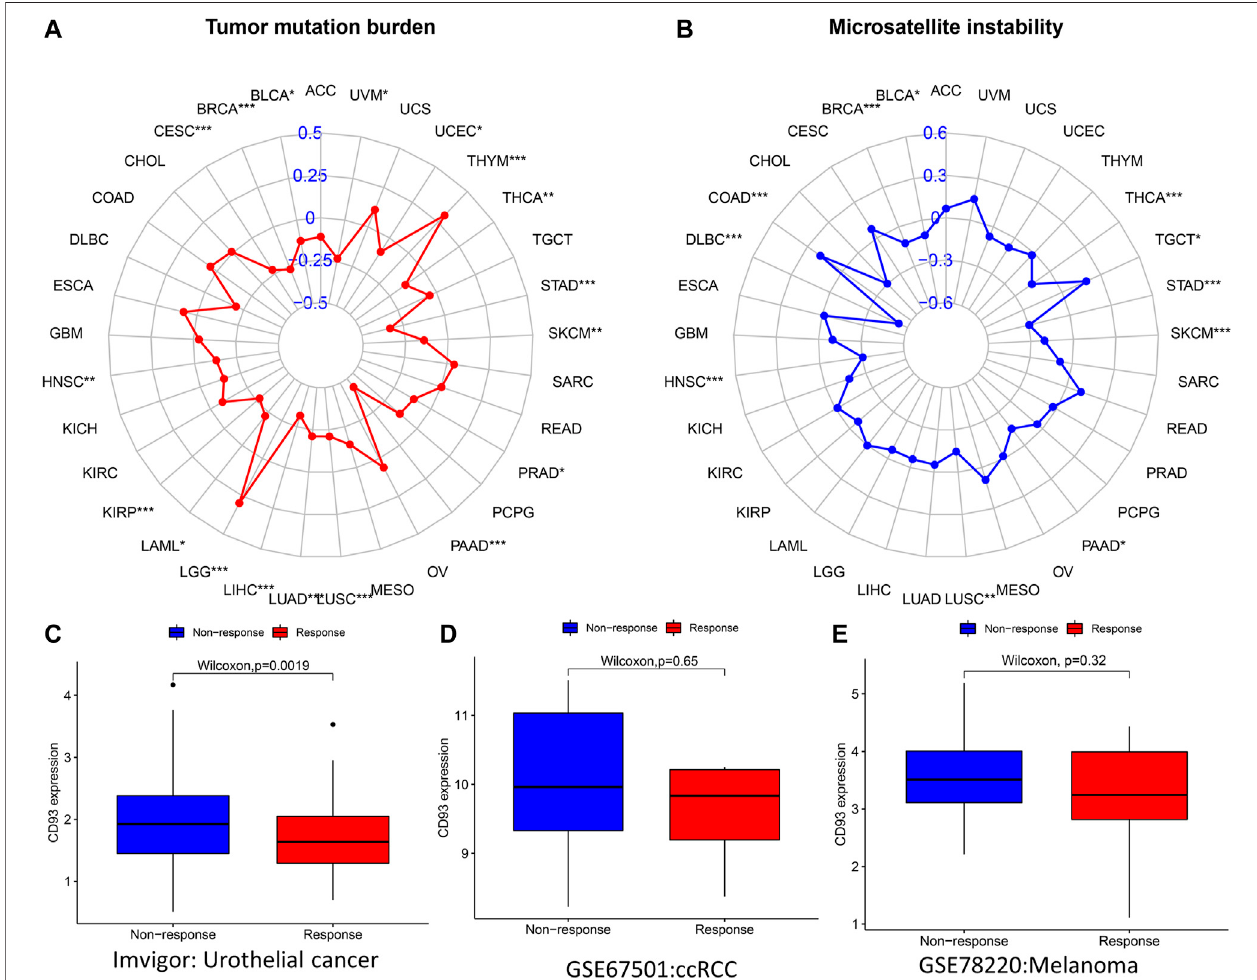
FIGURE 9 | Correlations between CD93 expression and both immunotherapeutic markers and immunotherapeutic response. (A,B) Correlations between CD93 expression and tumor mutation burden (TMB) and microsatellite instability (MSI) in cancers. (C – E) Relationship between CD93 expression and response to immunotherapy in three cohorts (IMvigor, GSE67501, and GSE78220). * p < 0.05, p < 0.01, *** p < 0.001.